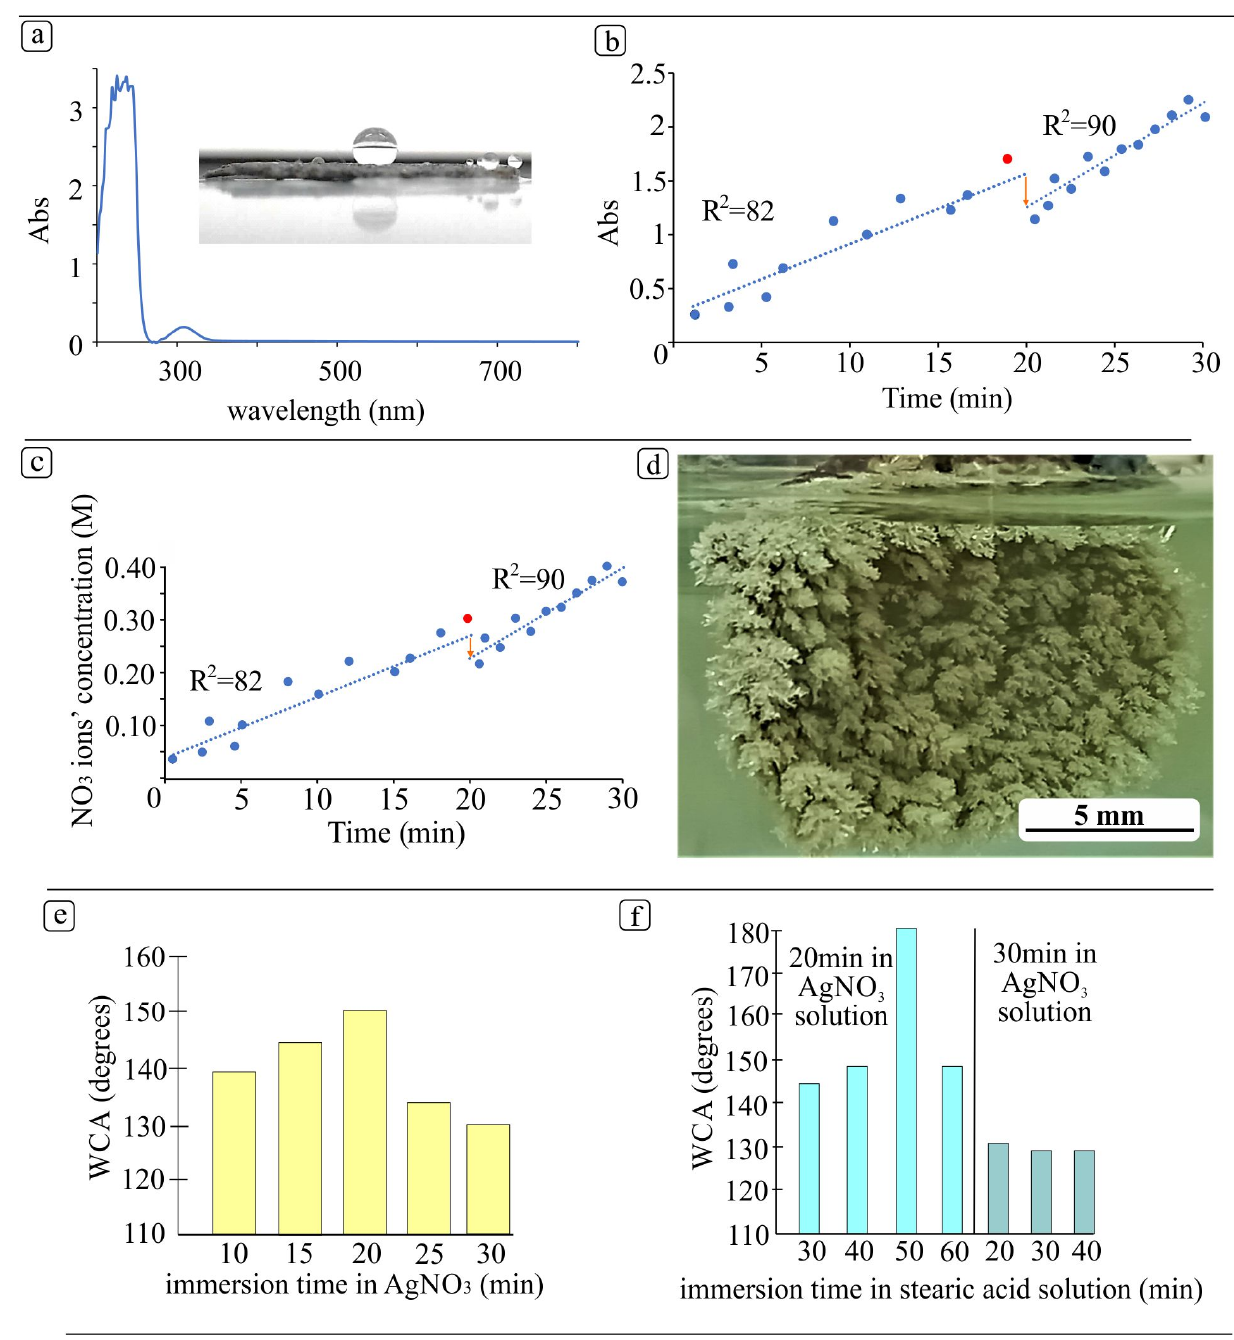
Figure 2. ( a ) Indicative UV-vis absorption spectrum, ( b ) nitrate ions’ absorbance as a function of time, ( c ) nitrate ions’ concentration as a function of time, ( d ) development of silver coating on the copper foam substrate, ( e ) WCA measurements for different minutes of immersion time in AgNO 3 , ( f ) WCA’s measurements for 20 min and 30 min of immersion time in AgNO 3 solution as a function of various immersion times in stearic acid solution.